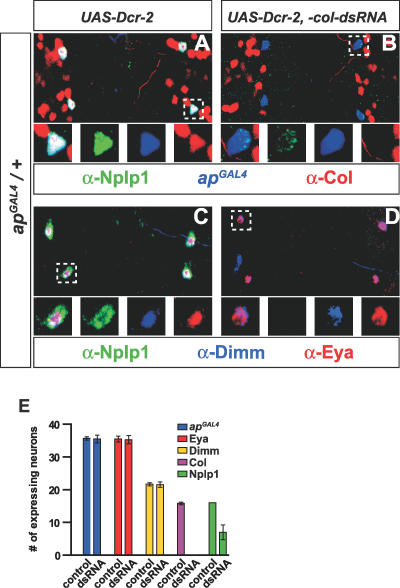
Postmitotic RNA Interference of col Leads to Loss of Nplp1 Expression, without Loss of ap, Eya, or Dimm(A and C) In the control, expression of Nplp1, ap, and Col (A), as well as Eya and Dimm (C) is readily detected in the third larval instar dAp neurons.(B and D) In the col RNAi, Col is completely and specifically lost from dAp (B), Nplp1 is down-regulated (B) or lost (D), whereas ap, Eya, and Dimm are not affected (B and D). As anticipated, col RNAi has no effect upon FMRFa expression in the third instar larvae (n = 5 VNCs; unpublished data). Dashed boxes outline the cells that are magnified at the bottom.(E) Quantification of the observed effects in dAp and Ap cluster neurons, in segments T1–A2.Genotypes: (A and C) and control in (E) UAS-Dcr-2/+; apGAL4, UAS-nmEGFP/+ and (B and D) UAS-Dcr-2/+; apGAL4, UAS-nmEGFP/+; UAS-col-dsRNA/+.